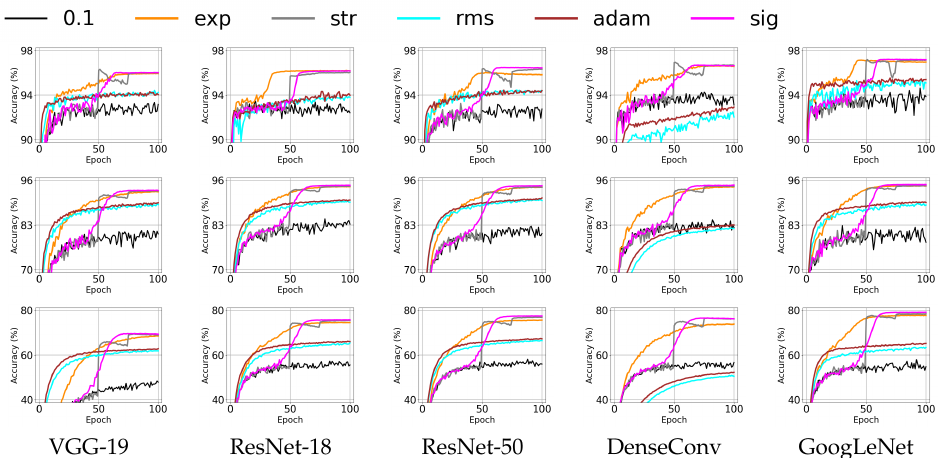
Figure 4. DNNs with learning rate decay. Accuracy curve over epochs for SVHN ( top row ), CIFAR-10 ( middle row ), and CIFAR-100 ( bottom row ) by SGD with different learning rate annealings: constant learning rate η = 0.1, exponential (exp), staircase (str), RMSprop (rms), Adam (adam), and sigmoid (sig): Per-epoch average of validation accuracy over 10 trials is shown in the y -axis where the range of accuracy is fixed for each data-set. Epoch (0, 1, 2, ..., 100) is shown in the x -axis.